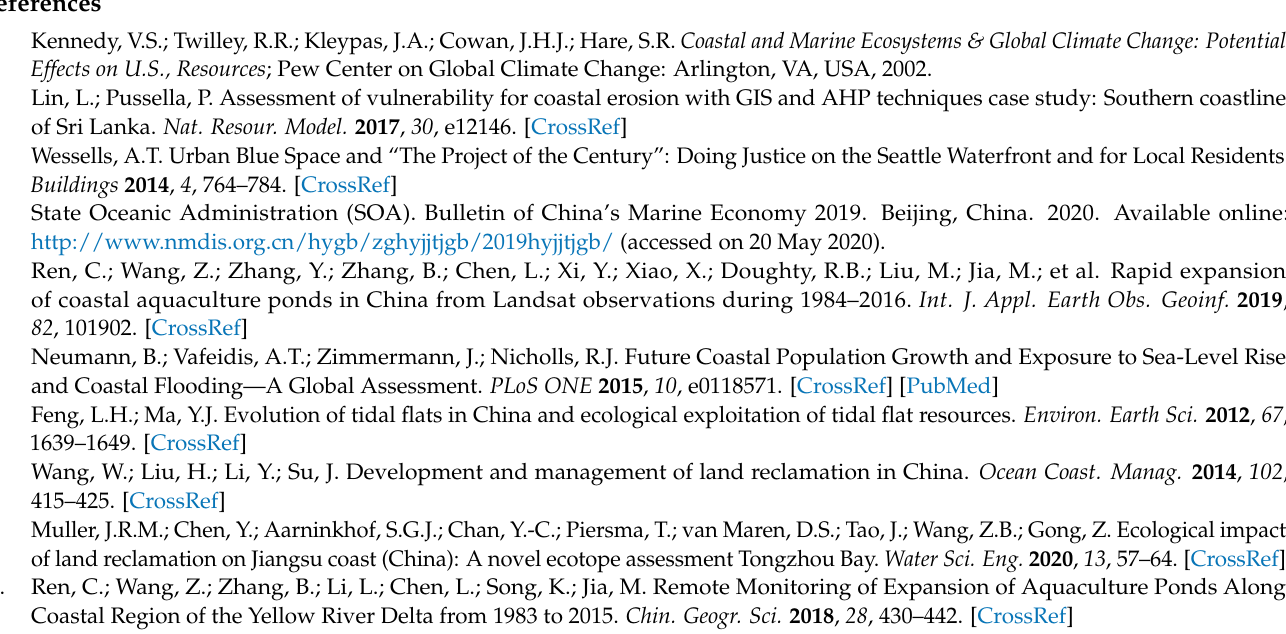
tidal flow field; Figure S2: Comparison of Simulated and measured tidal level in sea area; Figure S3: Relative error of simulated and measured tidal level; Figure S4: Tide Verification (Spring tide); Figure S5: Tide Verification (neap tide); Figure S6: Relative error of simulated and measured tide; Figure S7: Distribution of verification points on water quality; Figure S8: Comparison of simulated and measured data of COD concentration; Figure S9: Comparison of simulated and measured data of NH4-N concentration; Figure S10: Comparison of simulated and measured data of NOX-N concentration; Figure S11: Comparison of simulated and measured data of PO4-P concentration; Figure S12: Relative error of pollutant concentration simulated and measured values; Table